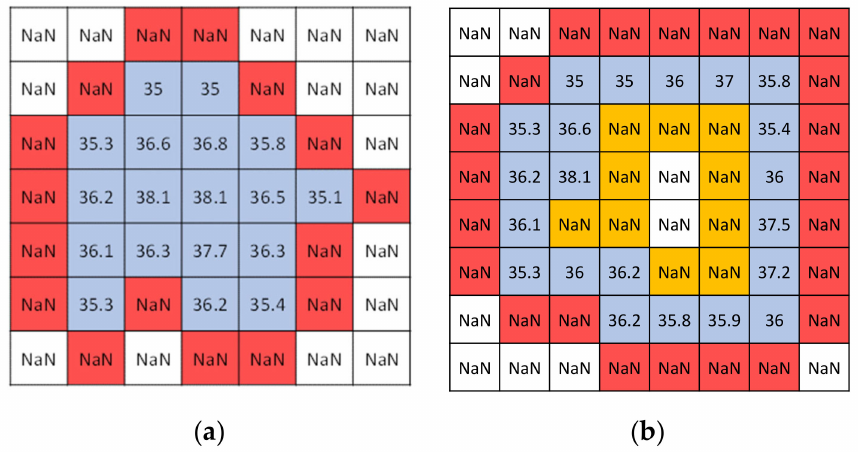
Figure 2. Two example sketches of an ROI, where f ( x , y ) ≥ 35 without ( a ) and with ( b ) a hole where the blue grids indicate the ROI and the red and yellow grids are the detected outer boundary and inner boundary (if there is a